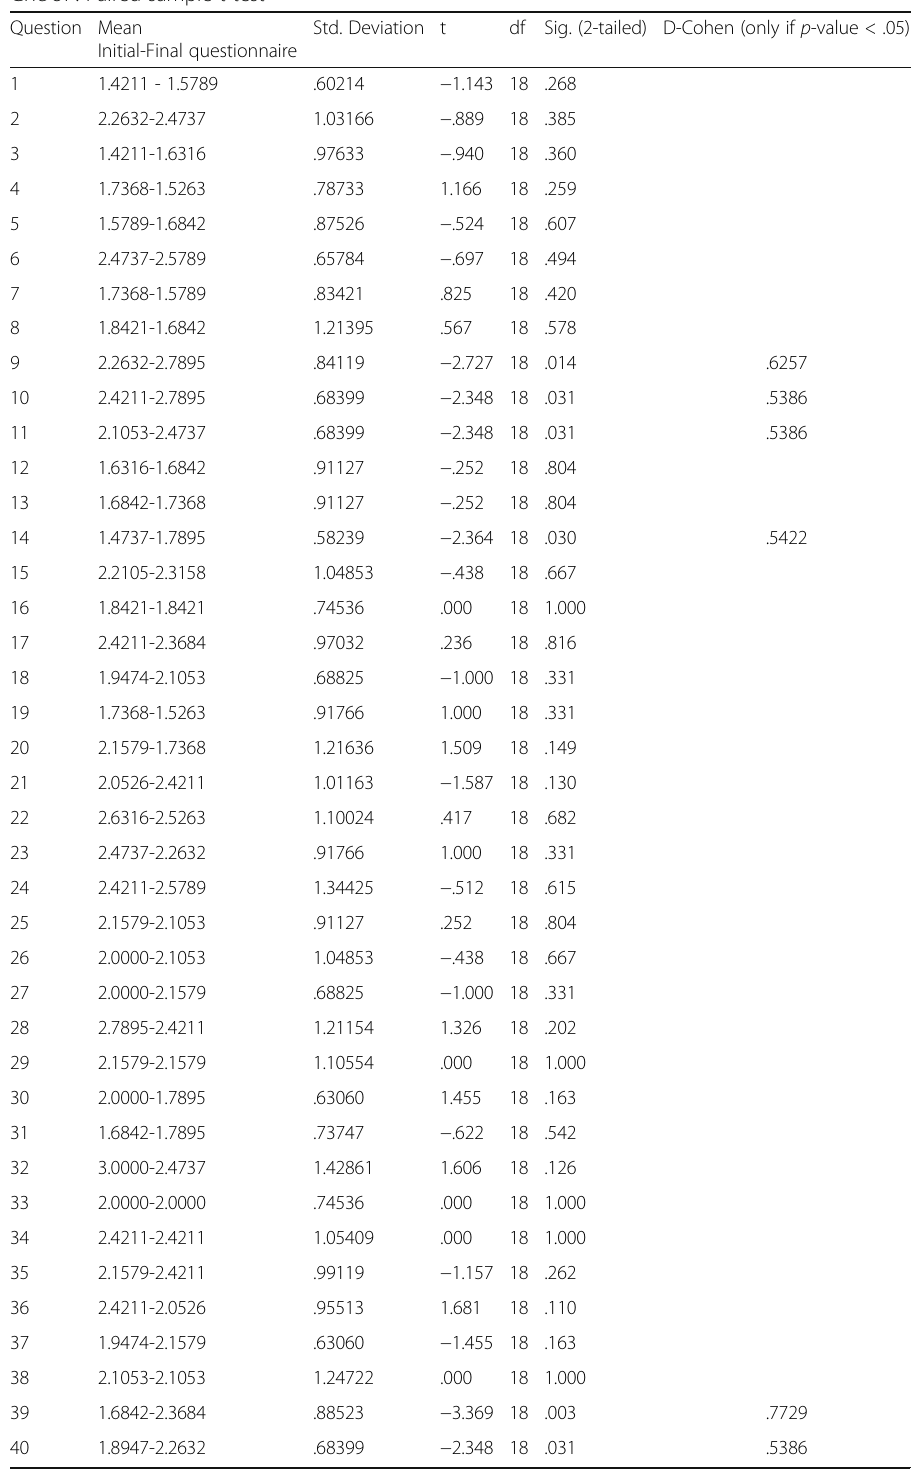
Table 2 Comparison between initial and final listening strategic behaviour by the EXPERIMENTAL GROUP. Paired sample t-test Question Mean Std. Deviation Initial-Final questionnaire